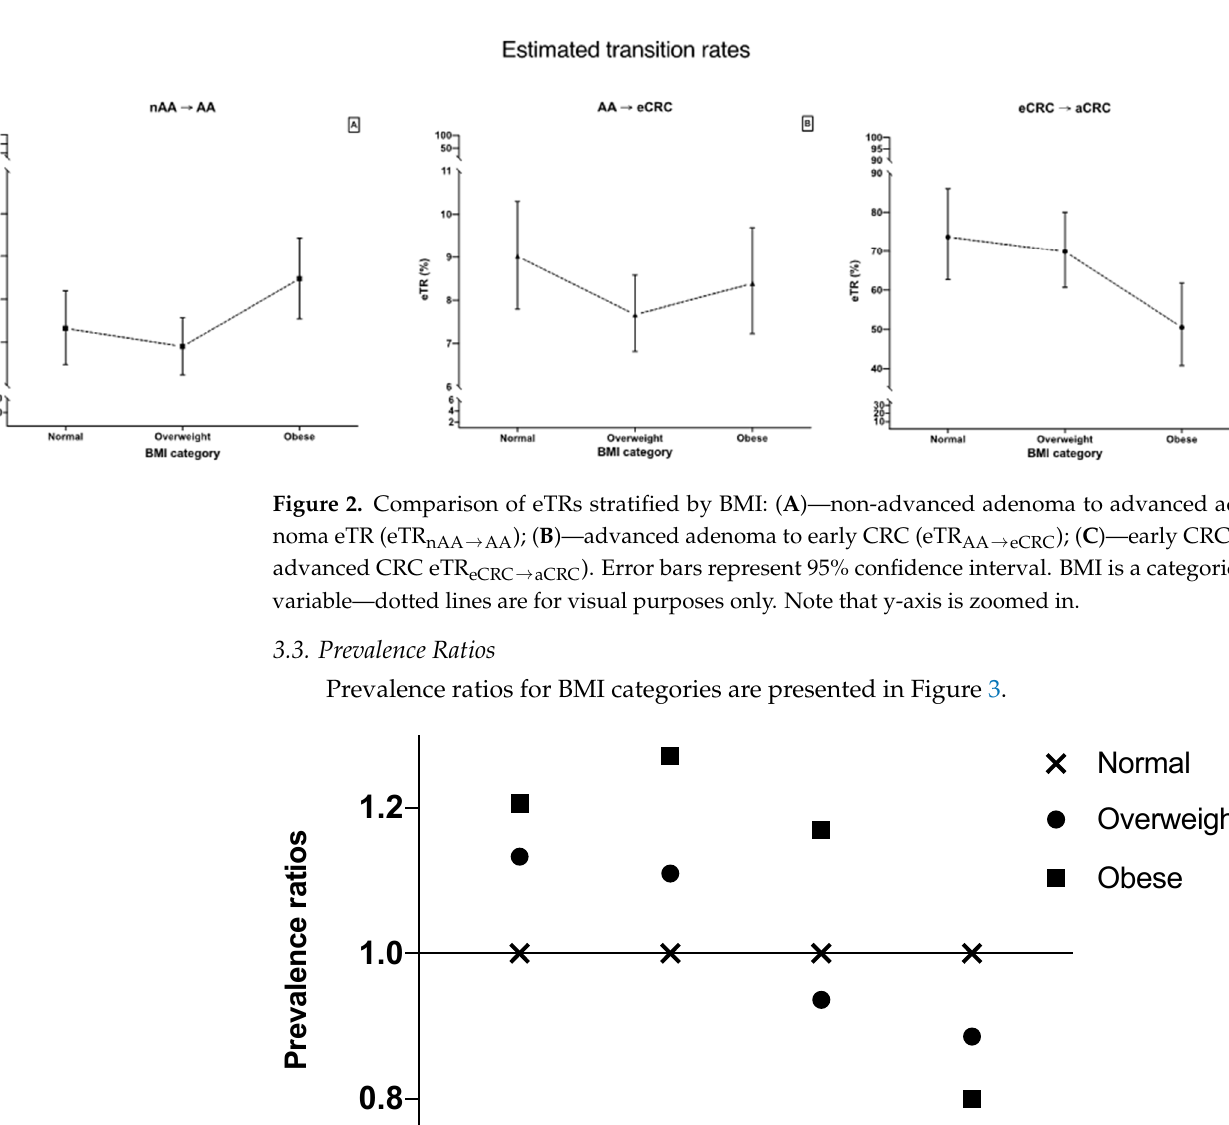
6 of 10 Figure 1. Comparison of adjusted prevalence: ( A ): adjusted prevalence of non-advanced adenoma stratified by BMI categories; ( B ): adjusted prevalence of advanced adenoma stratified by BMI cate- gories; ( C ): adjusted prevalence of early CRC stratified by BMI categories; ( D ) adjusted prevalence of advanced CRC stratified by BMI categories. Error bars represent 95% confidence interval. 3.2. Transition Rates eTR calculated as described in Methods section are presented in Figure 2. eTR for